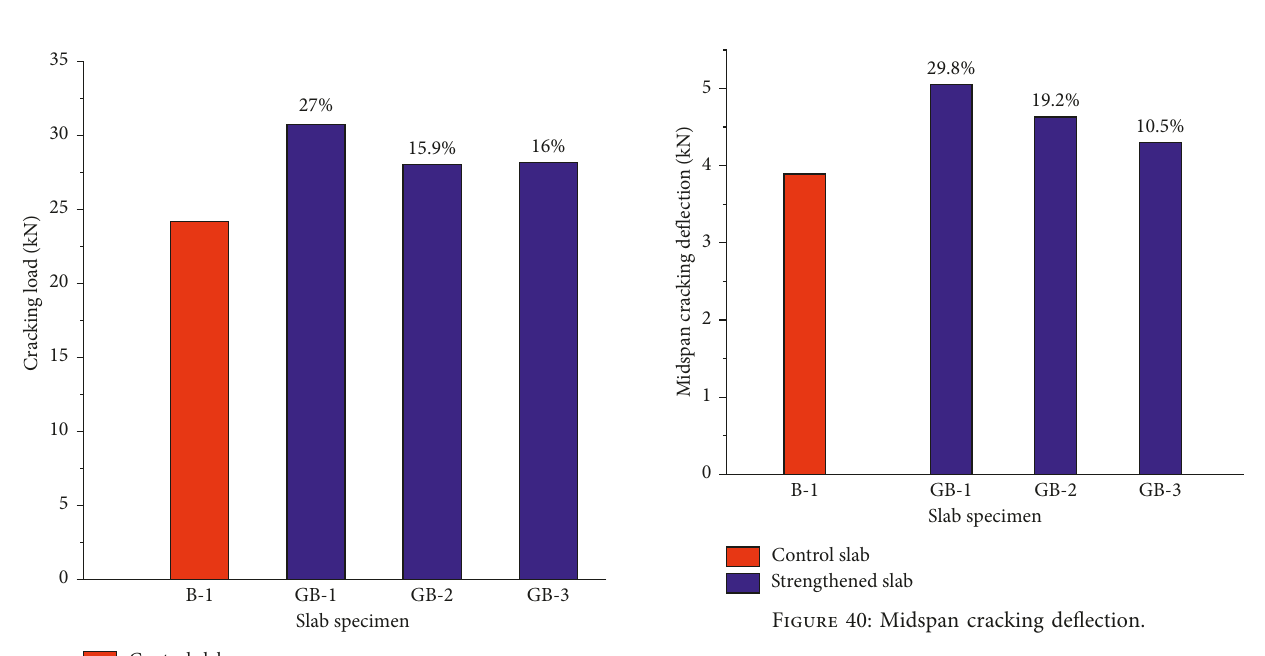
Figure 38: Strain comparison between screw-thread steels and CFRP bars and stone slab: (a) GB-1; (b) GB-2; (c) GB-3; (d) GB-4; (e) GB-5;